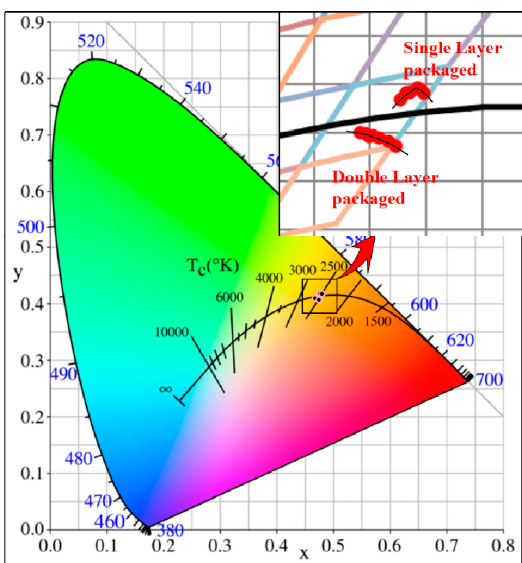
Figure 8. CIE-1931 chromaticity coordinates of traditional dispensing packaged filament and stacked-type packaged filament.